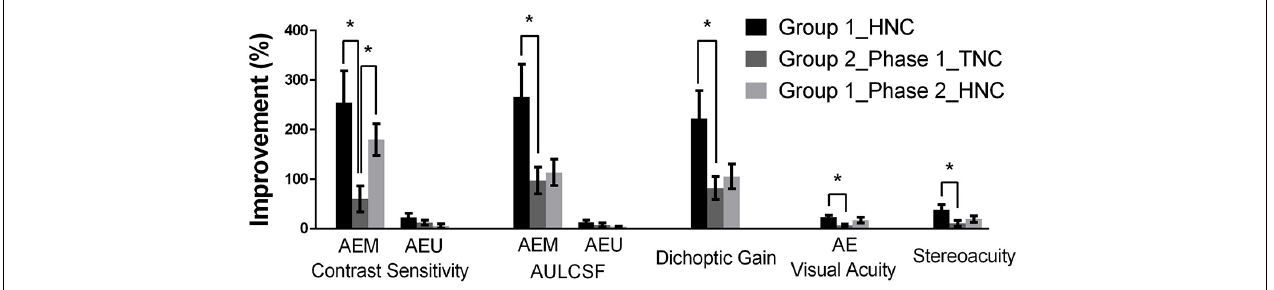
FIGURE 6 | Summary of training effects. Groups were represented by different colors: black (Group 1), dark gray (Group 2, Phase 1), and light gray (Group 2, Phase 2). Error bars represent SEM. * p < 0.05.